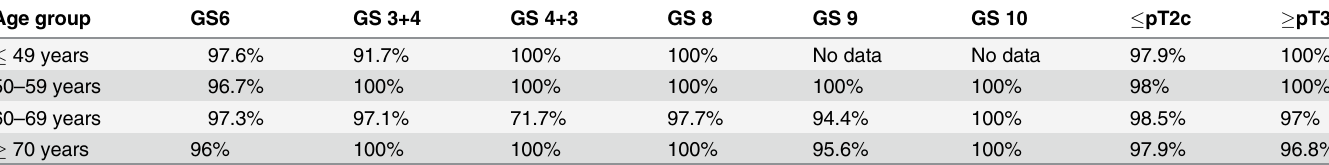
Table 6. Recognized tumors (%) biopsied according to “ new ” PSA cut offs stratified by age. Age group